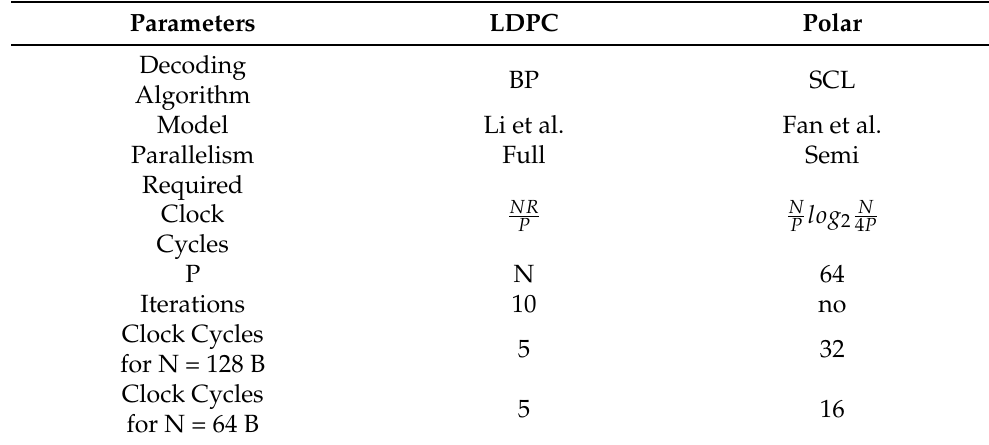
Table 4. Decoding algorithm clock